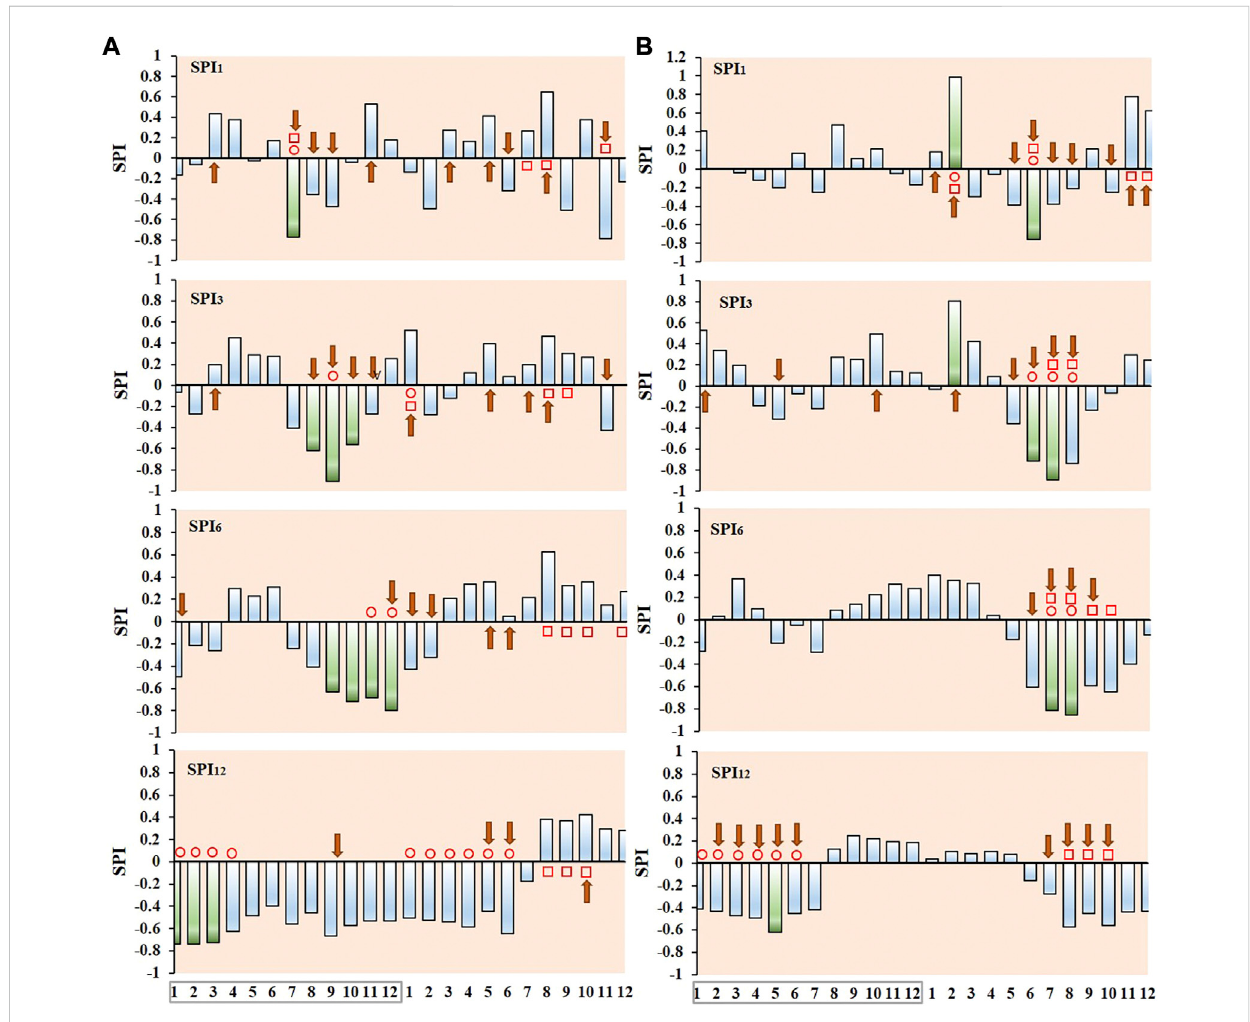
FIGURE 10 Mean SPI values at different timescales from SPI series in the northwest region. (A) El Niño and (B) La Niña years (boxed) and the year after these events. Same as Figure